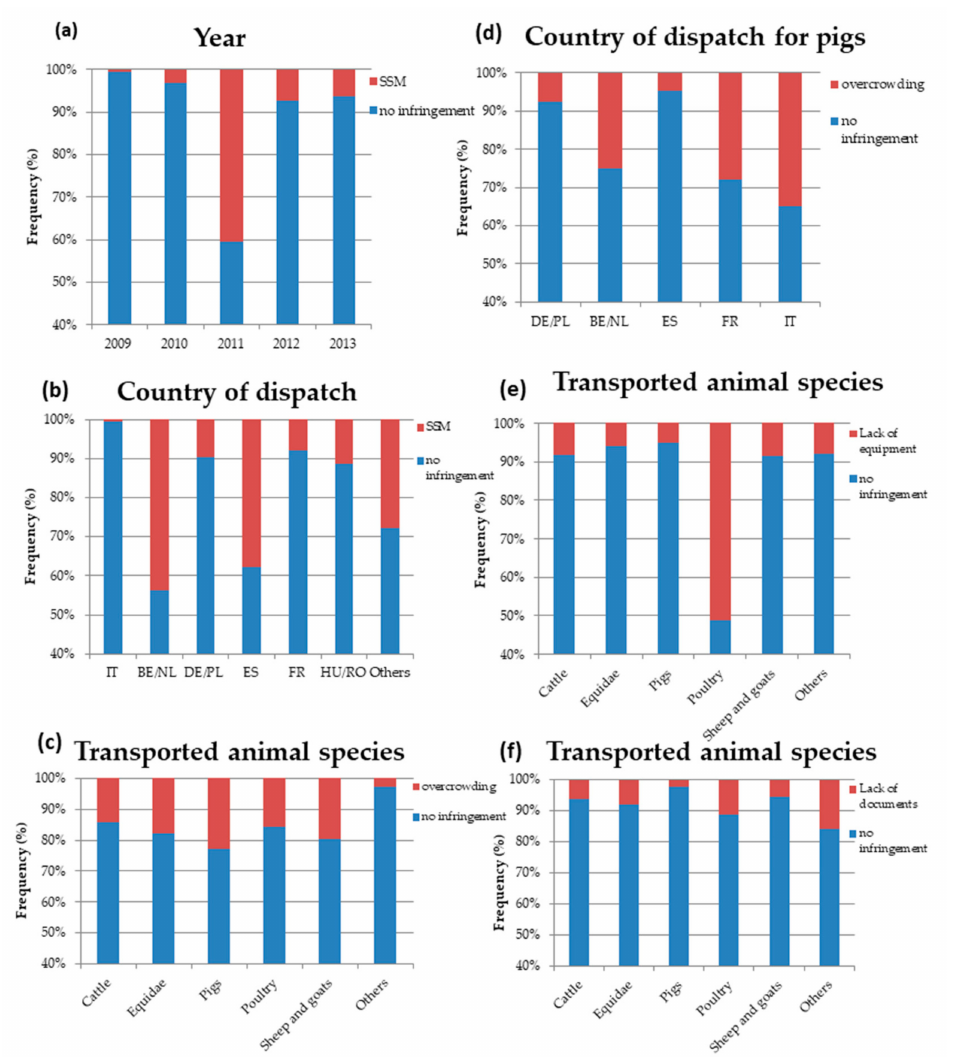
Figure 3. Probability of uncovering infringements due to missing a scheduled stop (SSM) for the considered years ( a ) and for the country of dispatch ( b ). Probability of uncovering infringements due to overcrowding by species ( c ) and by country of dispatch for pigs ( d ). Probability of uncovering infringements due to lack of equipment by species ( e ). Probability of uncovering infringements due to lack of documents by species ( e ). DE / PL: Germany / Poland; BE / NL: Belgium / the Netherlands; ES: Spain; FR: France; HU / RO: Hungary / Romania; IT: Italy; Other: China; Czech Republic; Denmark; Ireland; Lithuania; Slovakia; Slovenia; United Kingdom; and SSM: scheduled stop